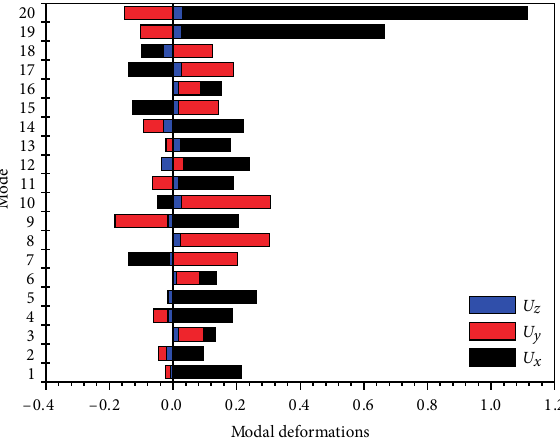
Fig. 12. Modal deformations of the first twenty modal shapes in the directions X , Y and placement of 0.133, and the bell-tower, with 0.074 of modal deformation. These modal shapes also can be used for justify the accelerometers positioning adopted during ambient vibration testing.